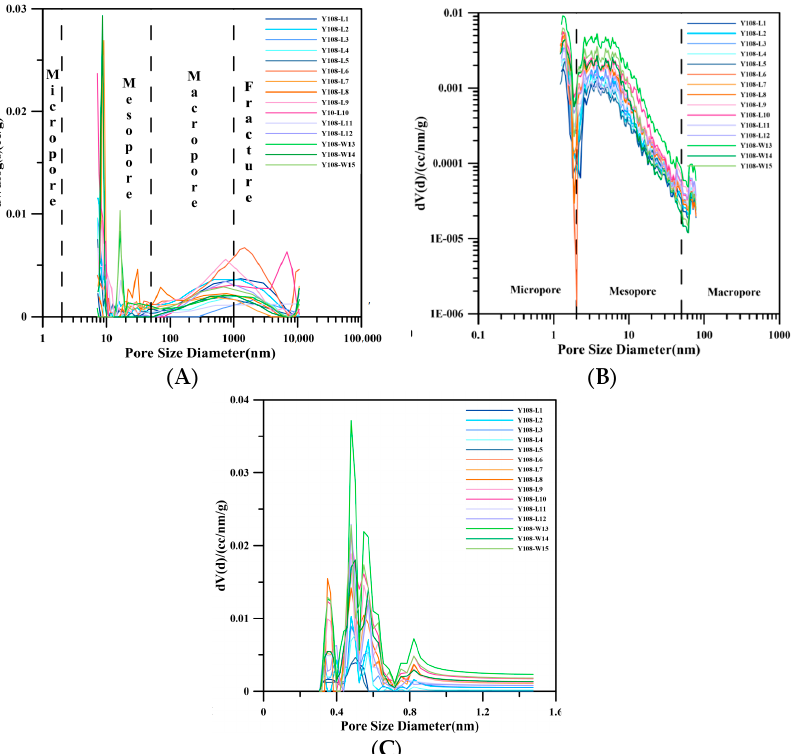
Figure 8. Validity analysis of PV and SSA data for different types of pores.